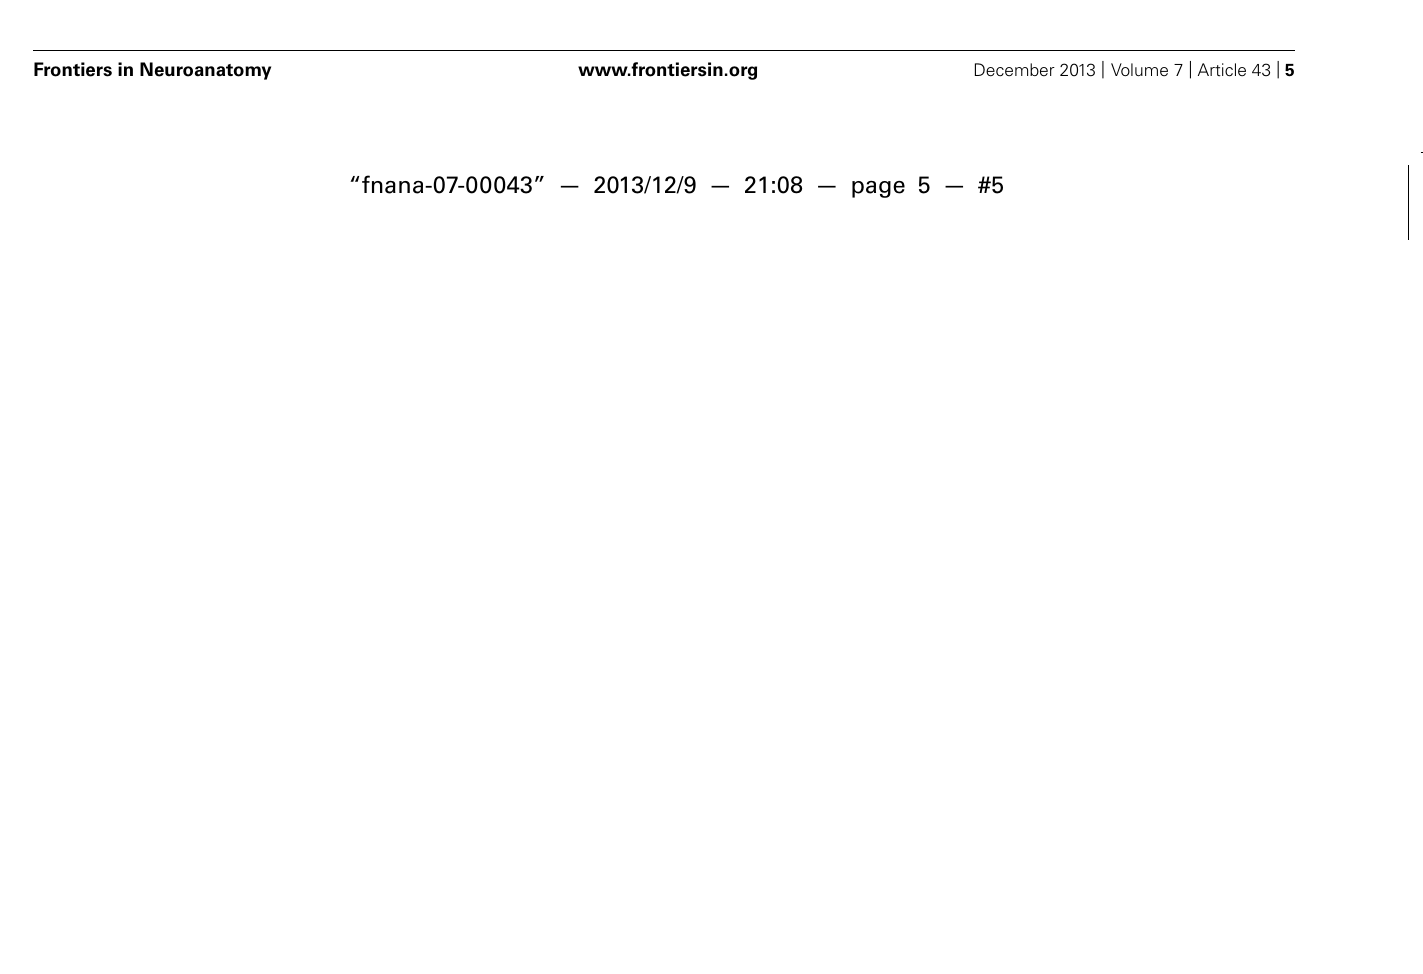
cell body. Abbreviations are as follows: ac, anterior commissural nucleus; AcbC: nucleus accumbens, core; AcbSh, nucleus accumbens, shell; mAcSh, medial AcbSh; vAcSh, ventral AcbSh; LV, lateral